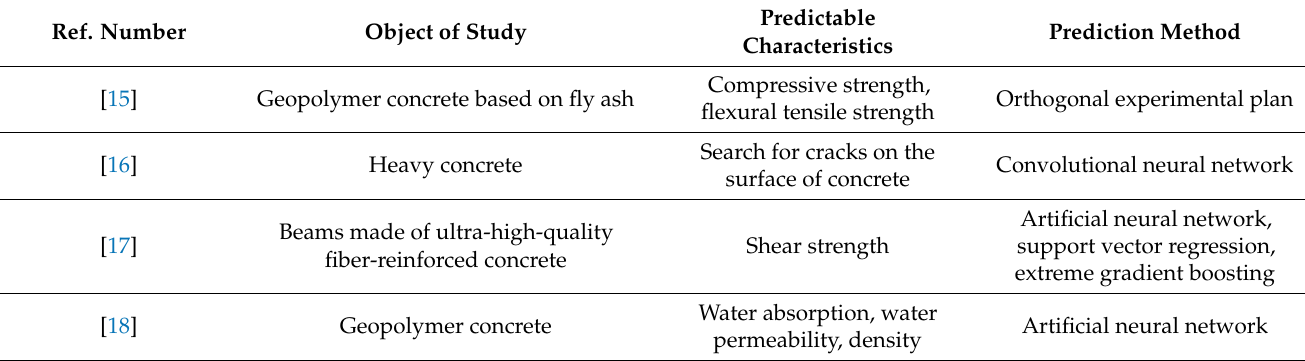
Table 1. Overview of the application of various machine learning methods for predicting the charac- teristics of concrete and products and structures from